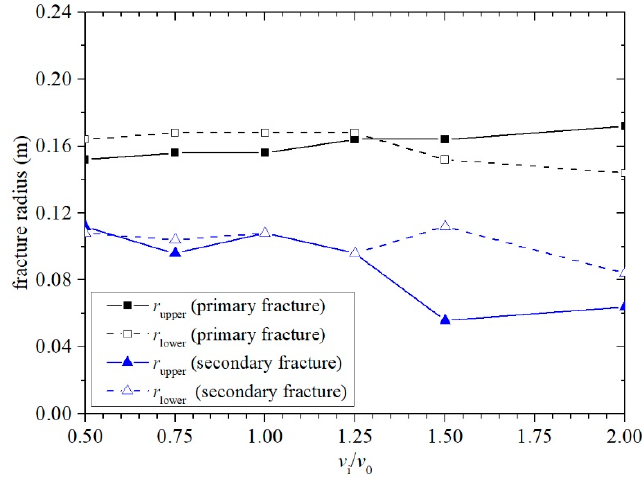
Figure 10. The fracture radius of models with different interlayer Poisson’s ratio at t = 2000 s.